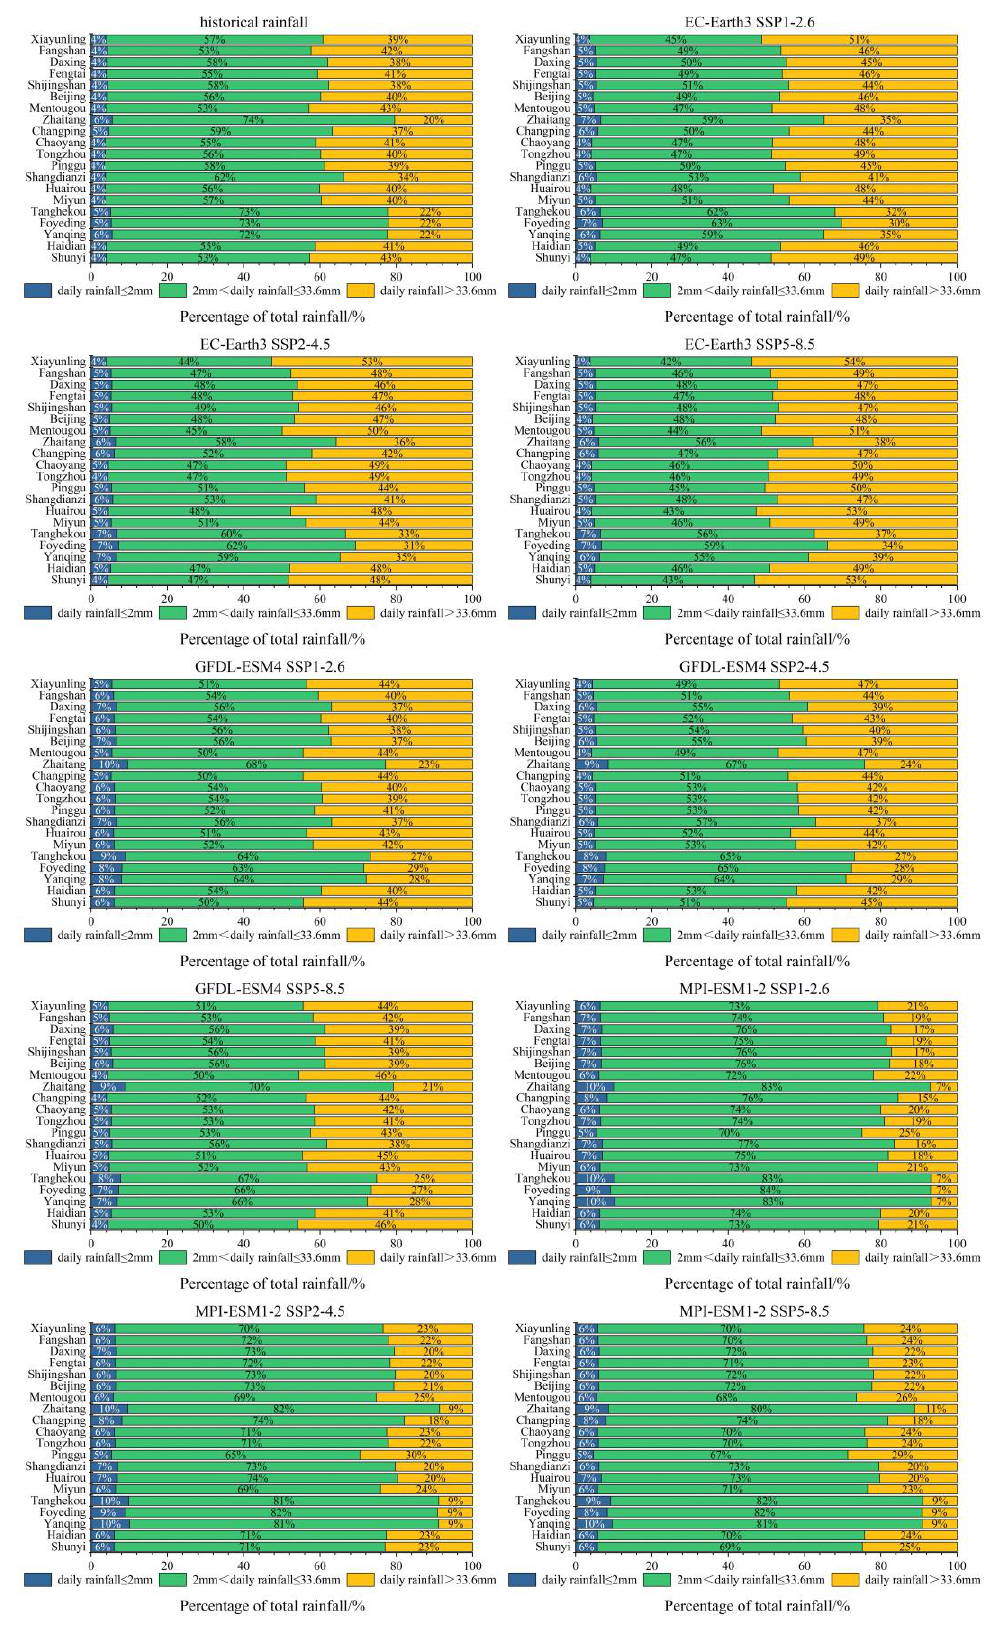
Figure 4. The proportion of different rainfall in Beijing .